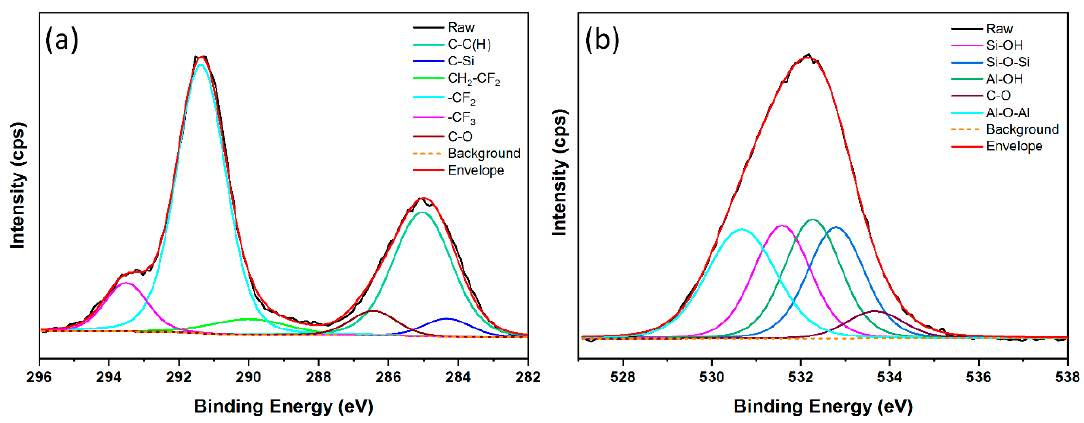
Figure 5. The high-resolution spectra of ( a ) C 1s and ( b ) O 1s.